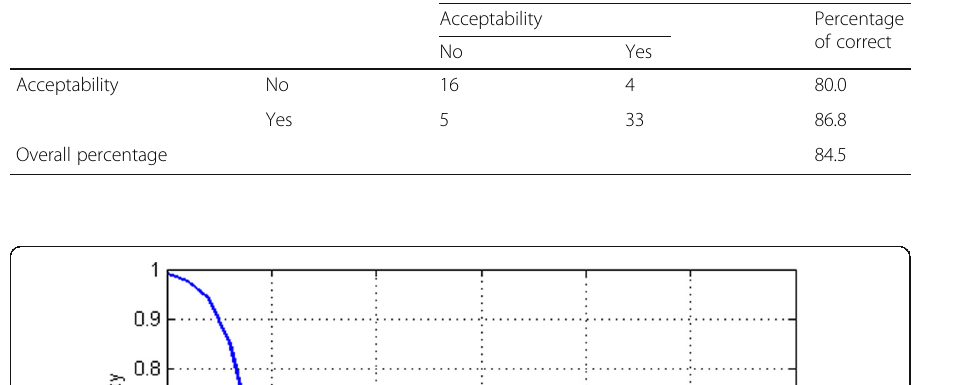
Table 13 Classification; observed vs. predicted Observed